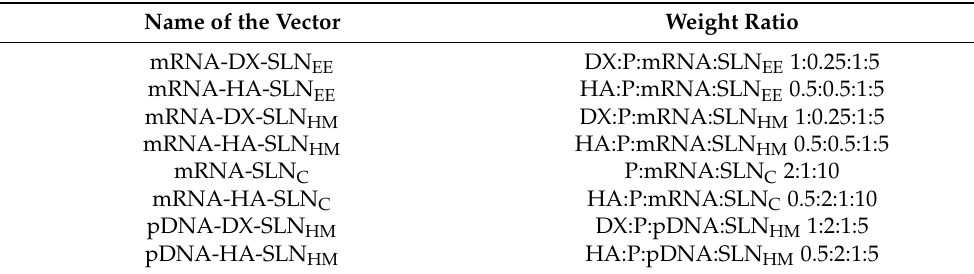
Table 1. Weight ratios of the